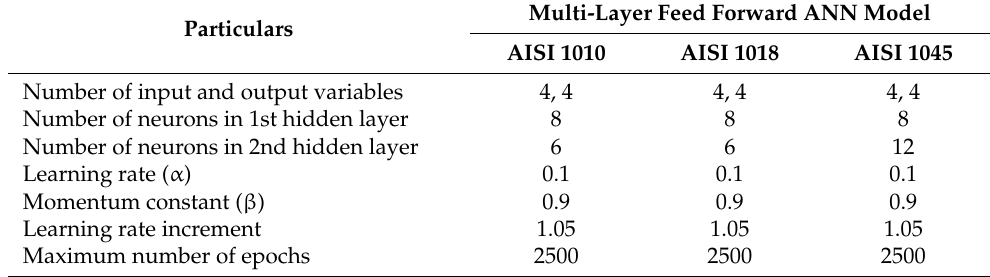
Table 3. ANN training parameters.